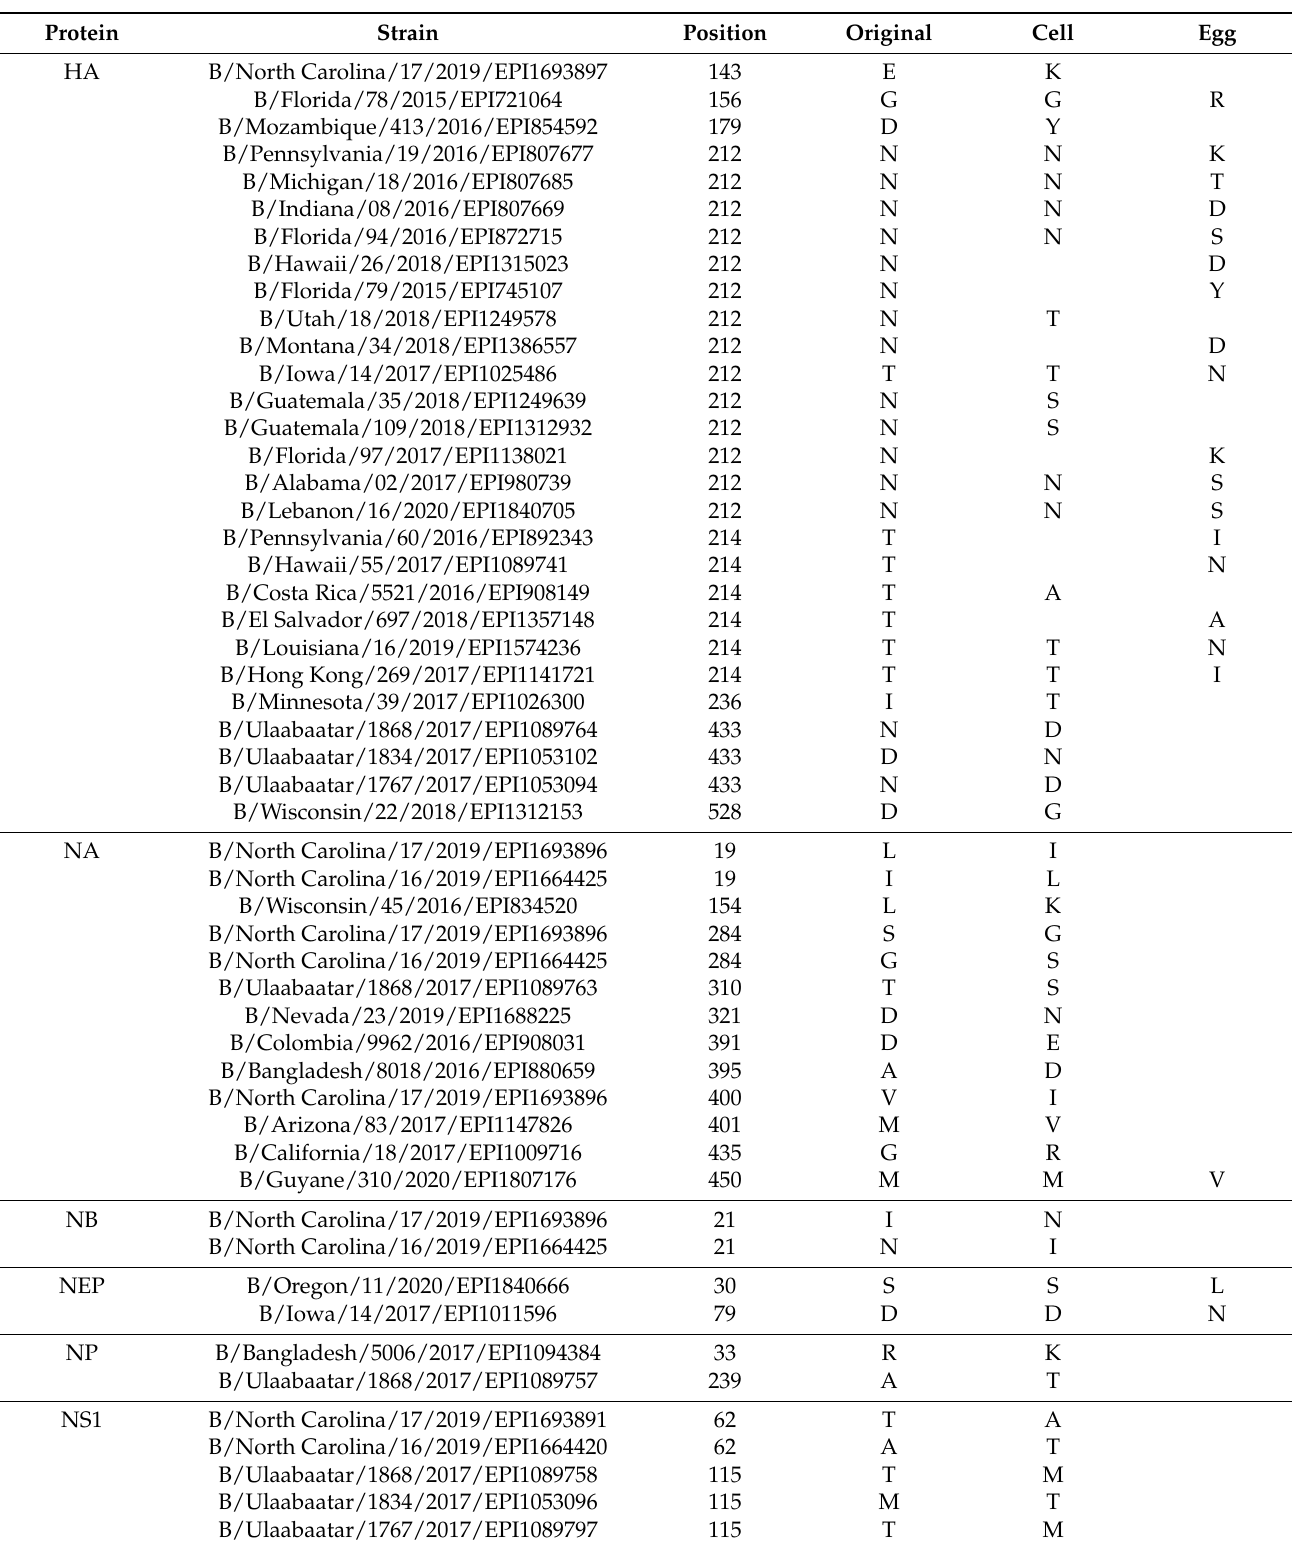
Table 3. Cell- and egg-adapted amino acid mutations of Victoria lineage IBVs from the paired clinical isolate samples available at the GISAID.